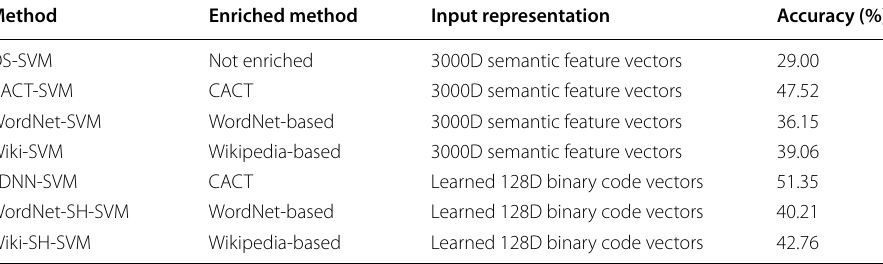
Table 1 Comparison among various classification methods